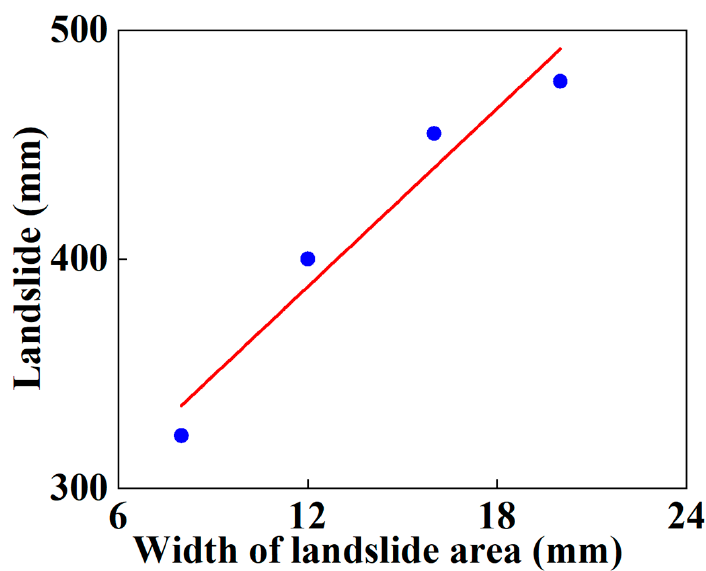
Figure 17. Variation in maximum landslide of the SWW-RTP with different soil widths.